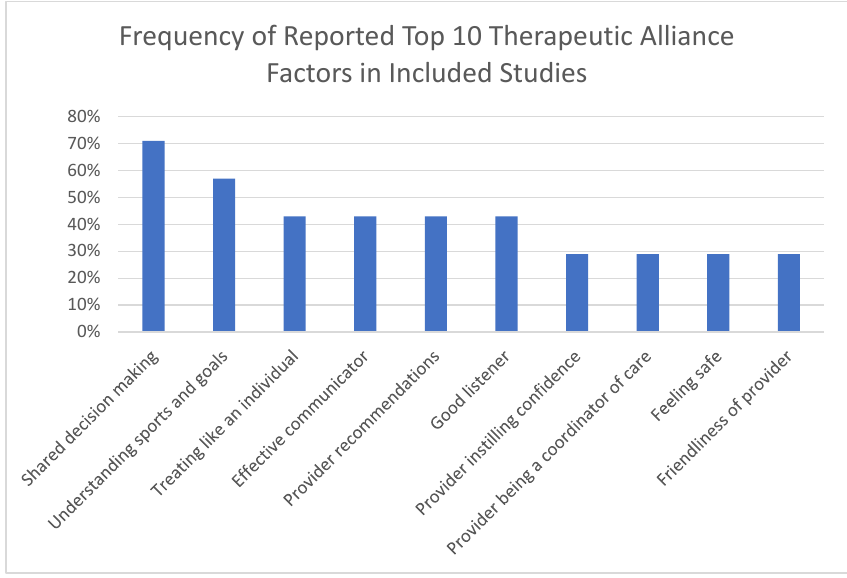
Figure 2. Frequency of top 10 reported therapeutic alliance factors in included studies. Note: Percentage on the y-axis represents the percent of included studies that reported the listed attributes. The x axis represents the top 10 most common listed attributes in the included studies with shared decision making being the most common.